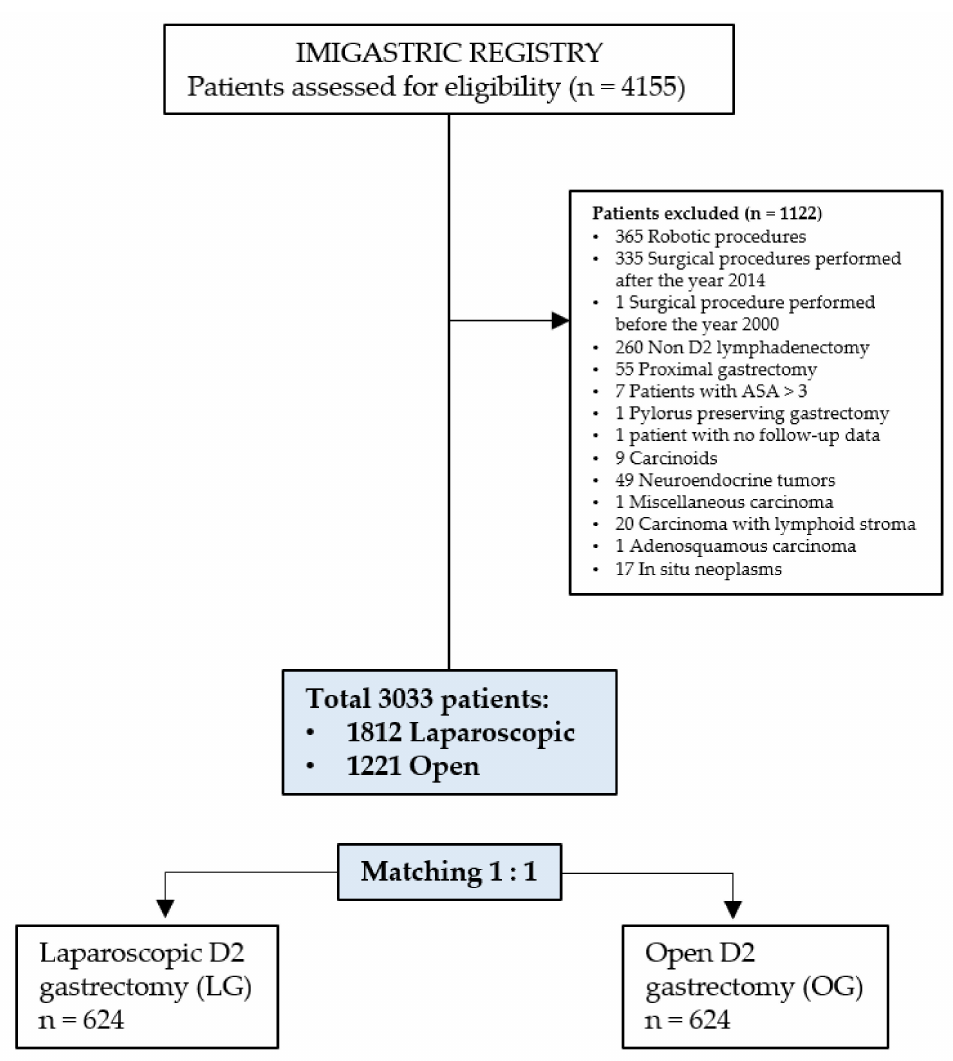
Figure 1. Study flow-chart. Table 1. Clinical, surgical, and demographic patient characteristics by surgical technique compared in the matched